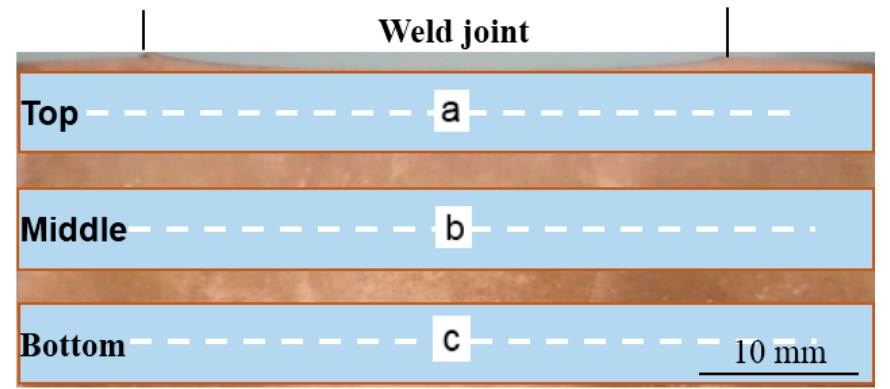
Figure 2. Schematic of three layers for tensile strength and vickers hardness, and electrical test and three locations ( a – c ) for the electron back-scattered diffraction (EBSD) test.